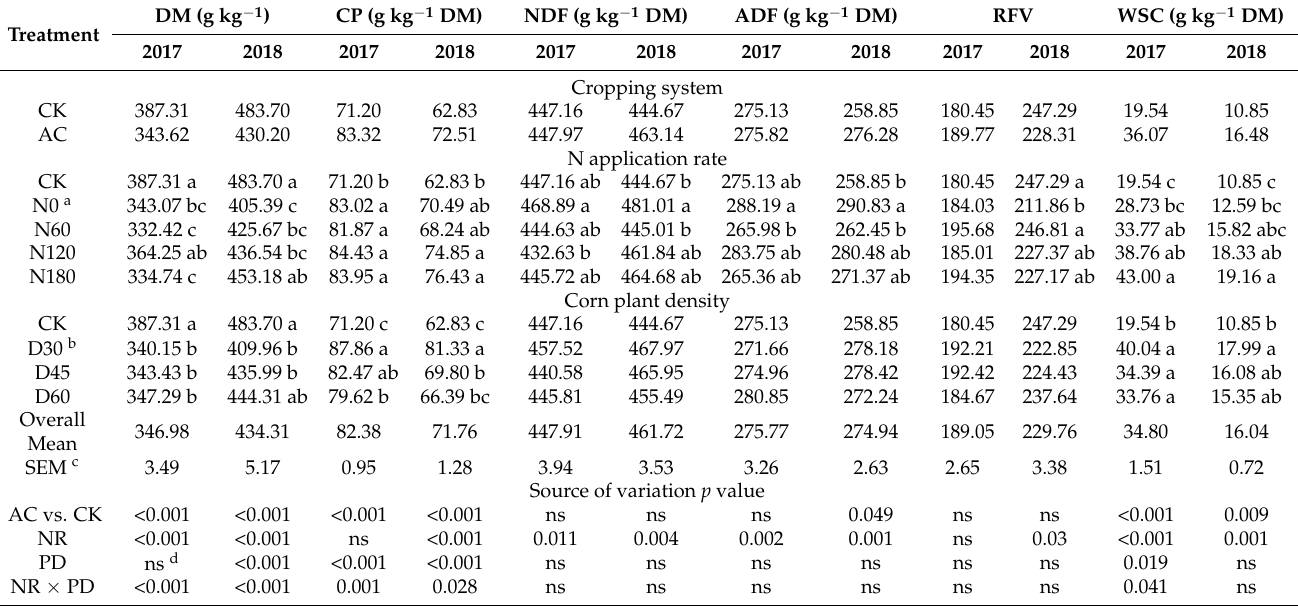
Table 3. Nutritive values of the mixed silage from alfalfa–silage corn relay intercropping (AC) and whole crop corn from silage corn monoculture control (CK) affected by nitrogen application rate (NR) and corn plant density